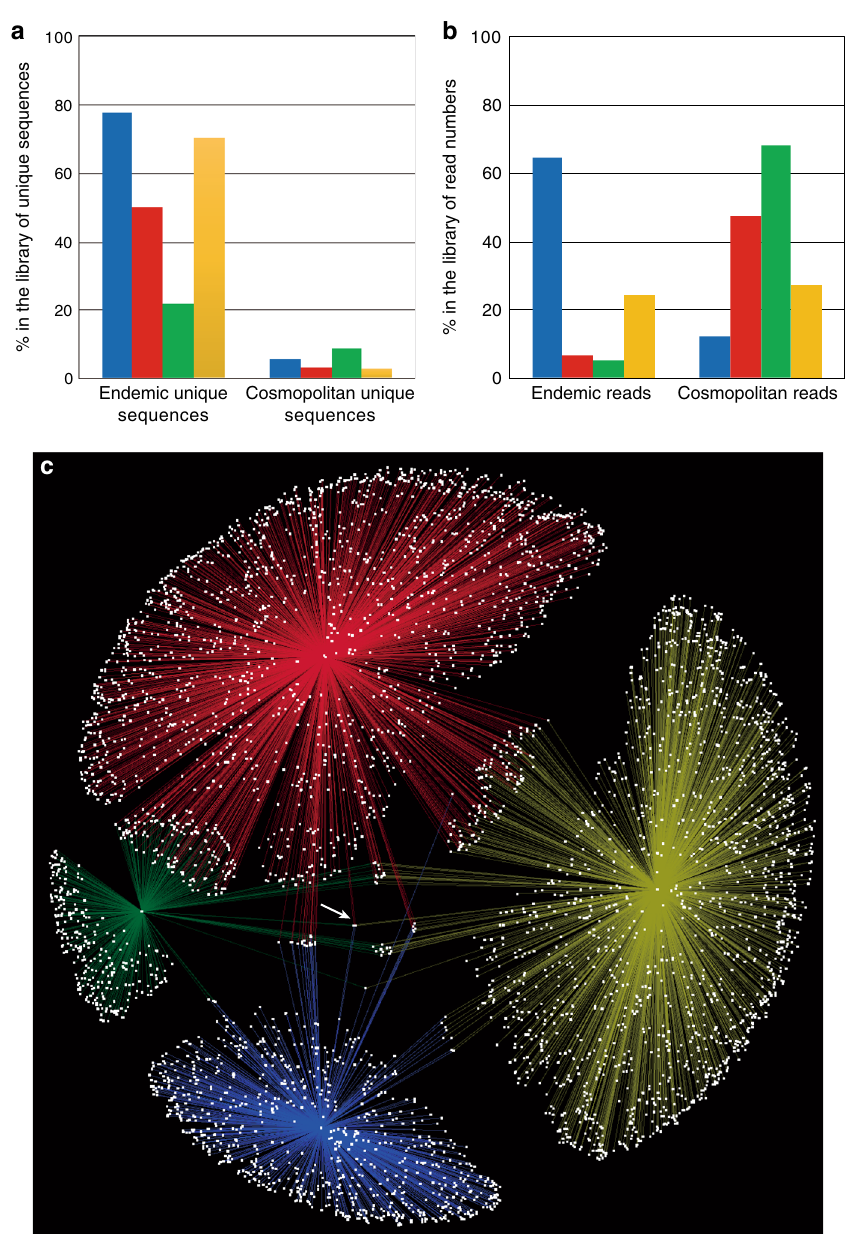
Fig. 3 Distribution of the endemic and bipolar cosmopolitan snow algae obtained from each region based on ITS2 unique sequences from high-throughput sequencing. OTUs and sequencing read numbers are shown. a Unique sequences. b Sequencing read numbers of the unique sequences. Bars are coloured according to geographical region of the glacier: blue, Antarctica; red, Svalbard; green, Greenland; yellow, Alaska. c Co-occurrence networks for ITS2 unique sequences of snow algae from both polar regions. Unique sequences are coloured according to geographical region of the glacier, as noted above. The arrow points to the cosmopolitan-distributed